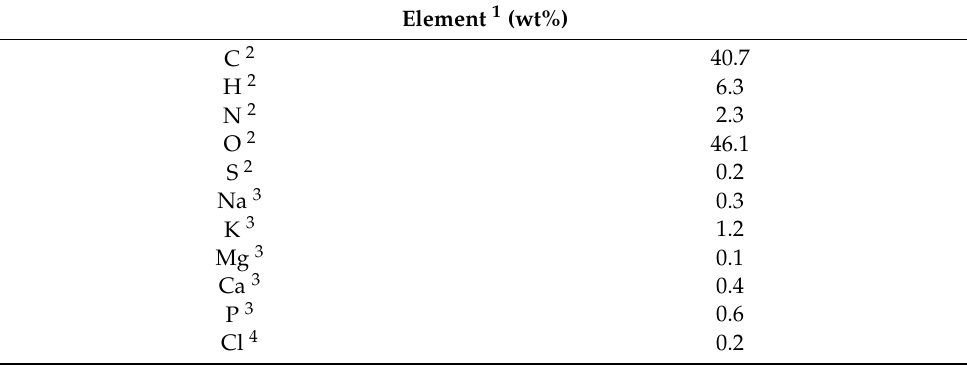
Table 2. Elemental analysis of the whey powders.